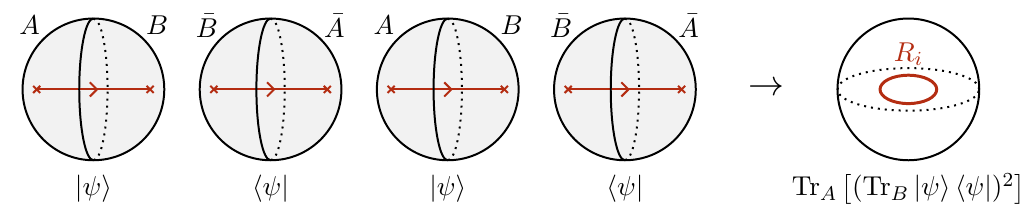
(cid:2) (cid:3) Figure 4 . We can calculate Tr A (Tr B | ψ i h ψ | ) 2 by gluing B with the neighboring ¯ B , corresponding to taking the partial trace over B , and A with the neighboring ¯ A , corresponding to the product of ρ A . The last ¯ A is glued to the first A , corresponding to the trace over A